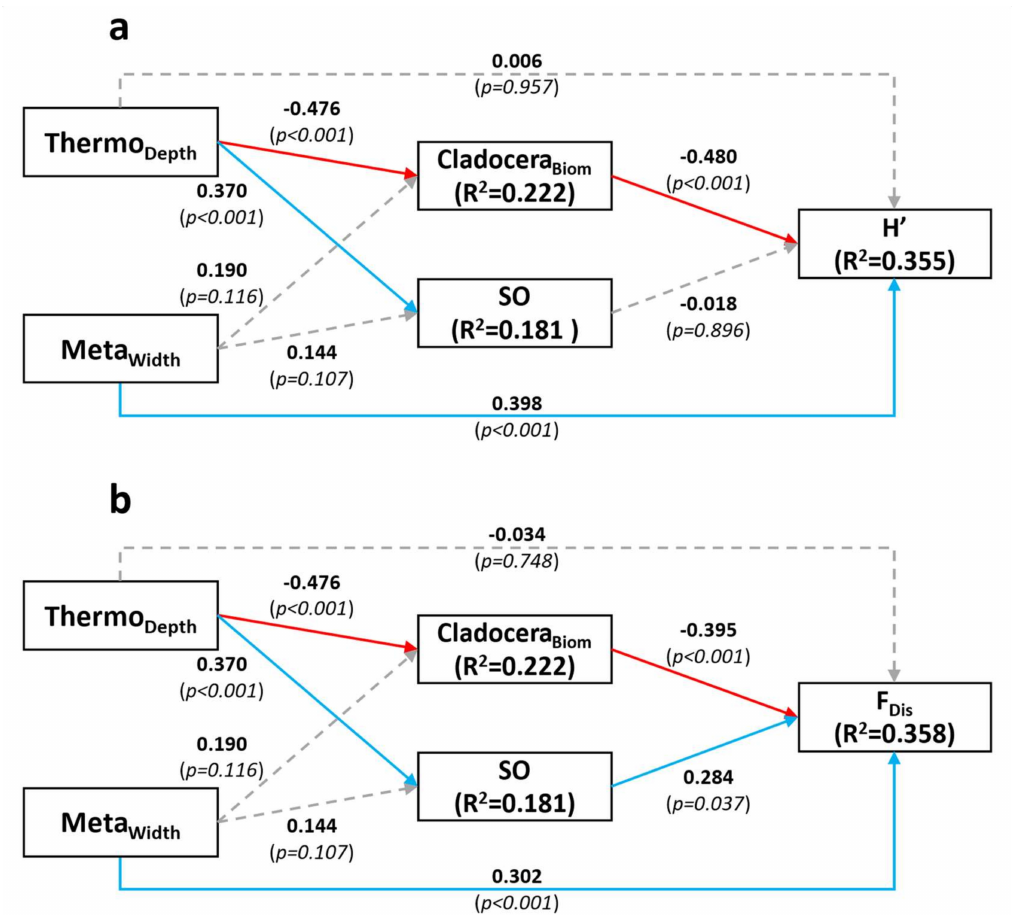
Figure 4. Structural Equation models for H’ ( a ) and F Dis ( b ). Dashed grey arrows represent non-significant relationships. Blue arrows represent significant positive relationship and red arrows represent significant negative relationship. Results shown are standardized coefficients and p -value (between parentheses), as well as R 2 scores for endogenous variables. Ab- breviations are as follows: Thermo Depth = thermocline depth, Meta Width = metalimnion width, Cladocera Biom = cladoceran biomass, SO = spatial overlap, H’ = Shannon diversity index, F Dis = Functional